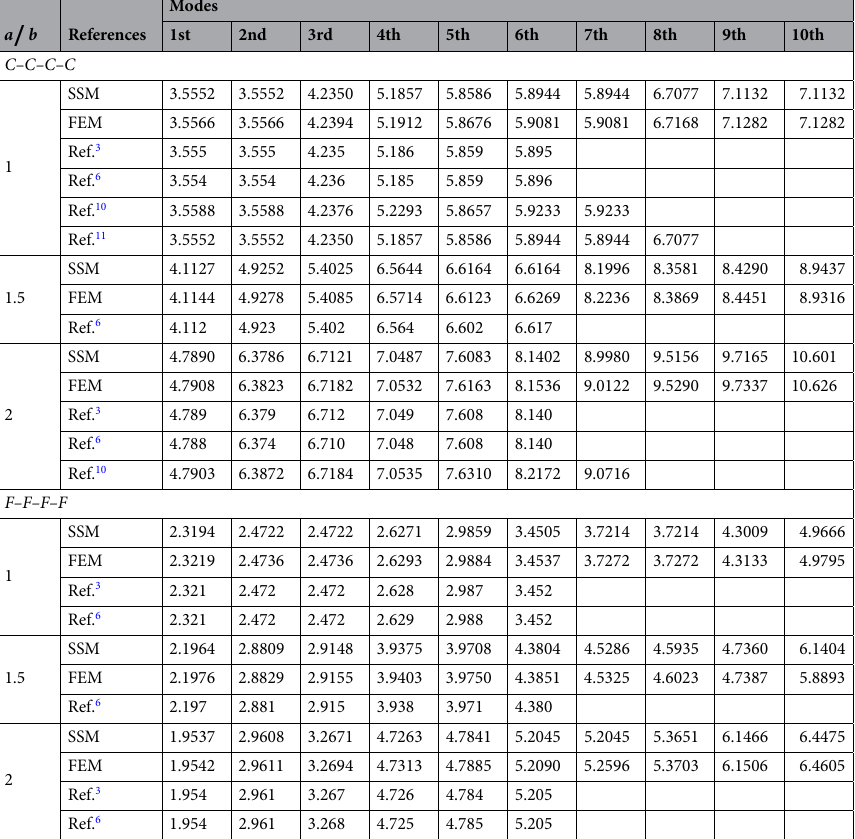
Table 3. The first ten frequency parameters ( (cid:31) iso ) of isotropic plates with ν = 0.3 .